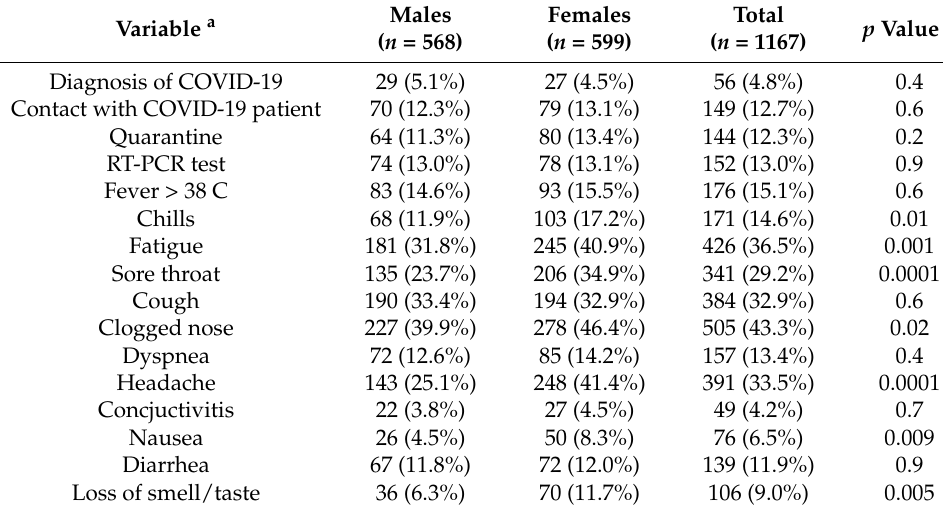
Table 1. History of COVID-19 infection, quarantine, molecular testing, and symptoms experienced in the period March-October in the study group, according to sex. The table shows the absolute and relative (% in the brackets) frequencies of the variables.